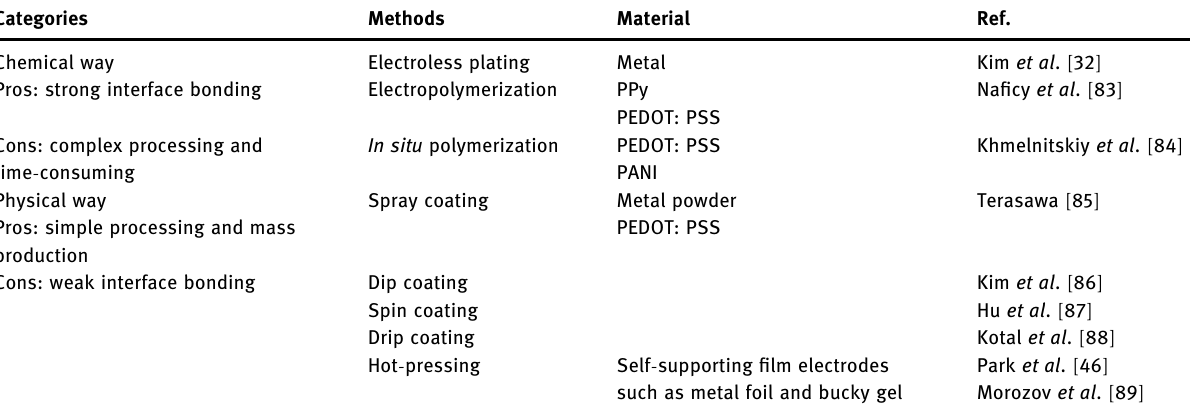
Table 2: Chemical and physical fabrication approaches of IL - iEAP